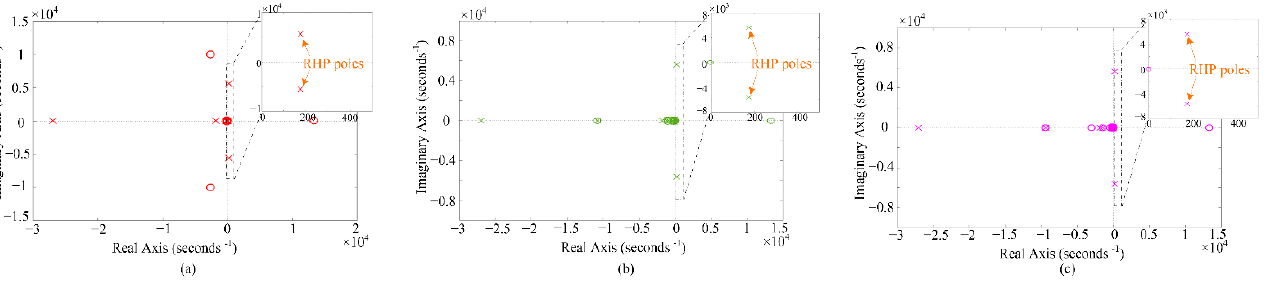
Figure 9. Pole-zero map of transfer functions with voltage droop: ( a ) G icd _cl_dr ( s ); ( b ) G icd ref_ icq _dr ( s ); ( c ) G icq ref_ icd _dr ( s ).